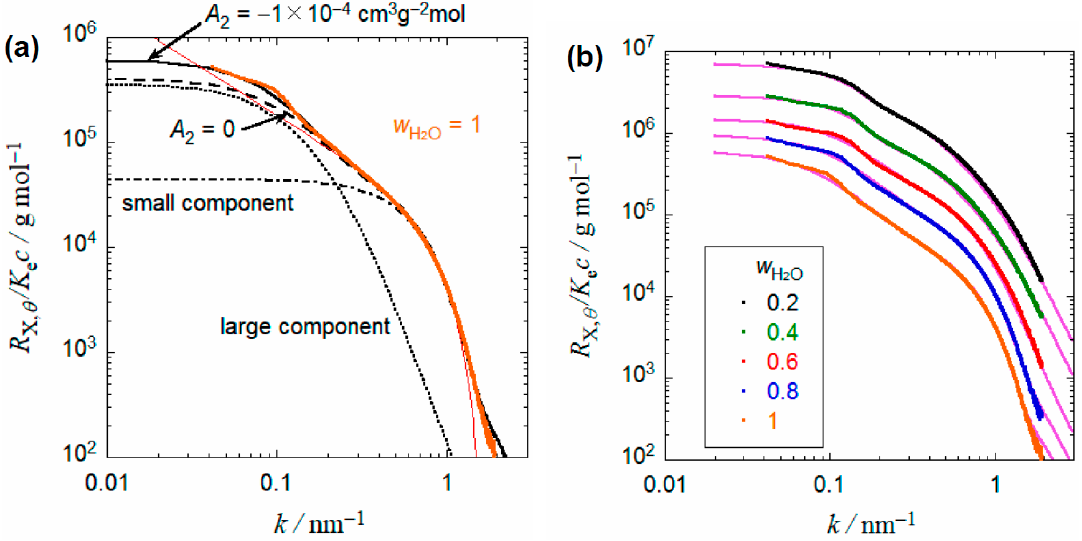
Figure 5. Fitting results for SAXS scattering functions.